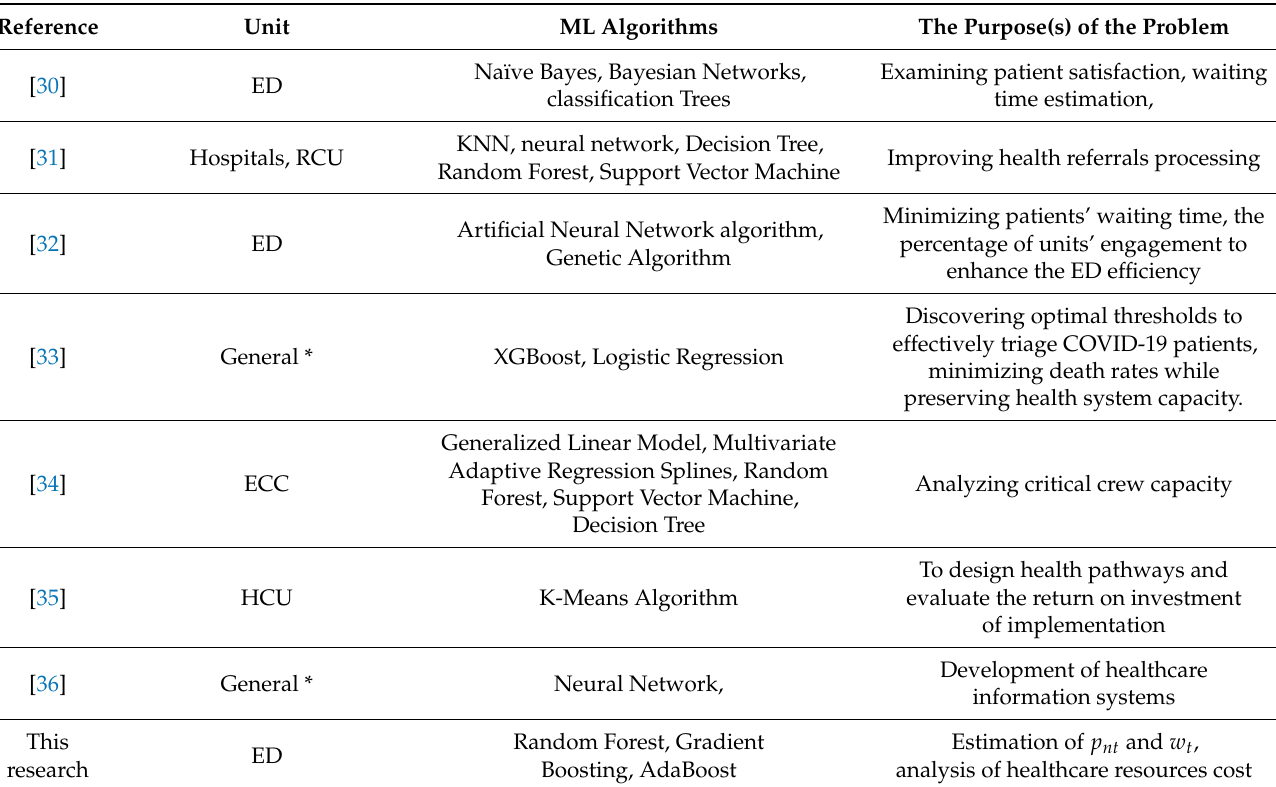
Table 1. Studies related to the field of health management used by the DES model–ML